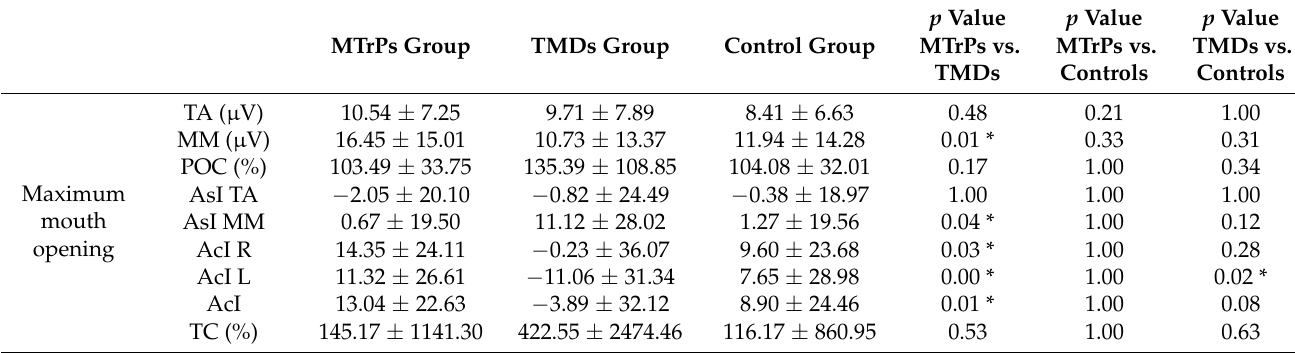
Table 5. Comparison of the mean values ( ± SD) of bioelectric activity of temporalis anterior (TA), masseter muscle (MM) and electromyographic indices between groups during maximum mouth opening.